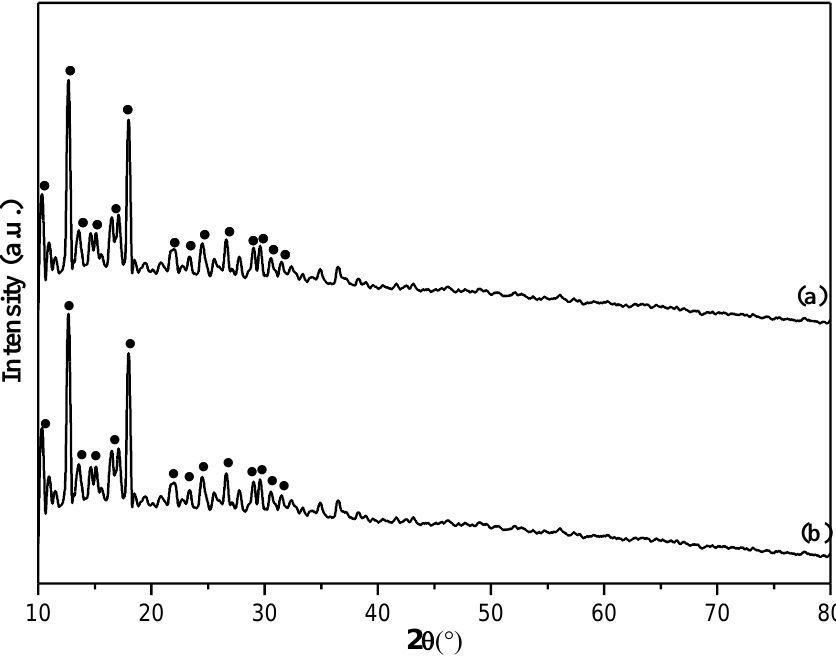
Figure 2. X-ray diffraction (XRD) patterns of Co-ZIF catalyst. ( a ). fresh, ( b ). after reaction.